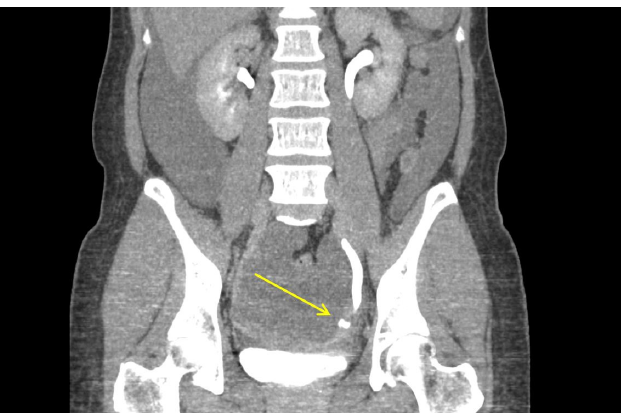
Figure 2. Sagittal image of urography CT (computed tomography) showing left distal ureteral contrast leakage with profuse amount of fluid collection in the abdominal cavity.